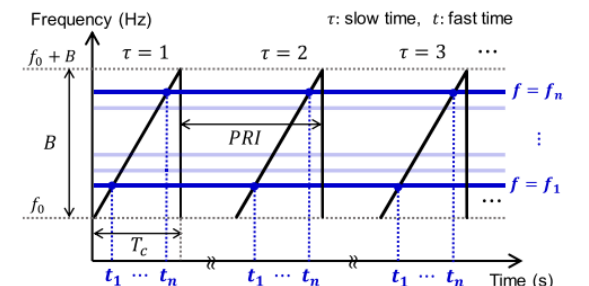
Figure 3. Example of transmitted chirp-signal frequency pattern from FMCW radar. Reprinted with permission from [26]. © 2020, IEEE.